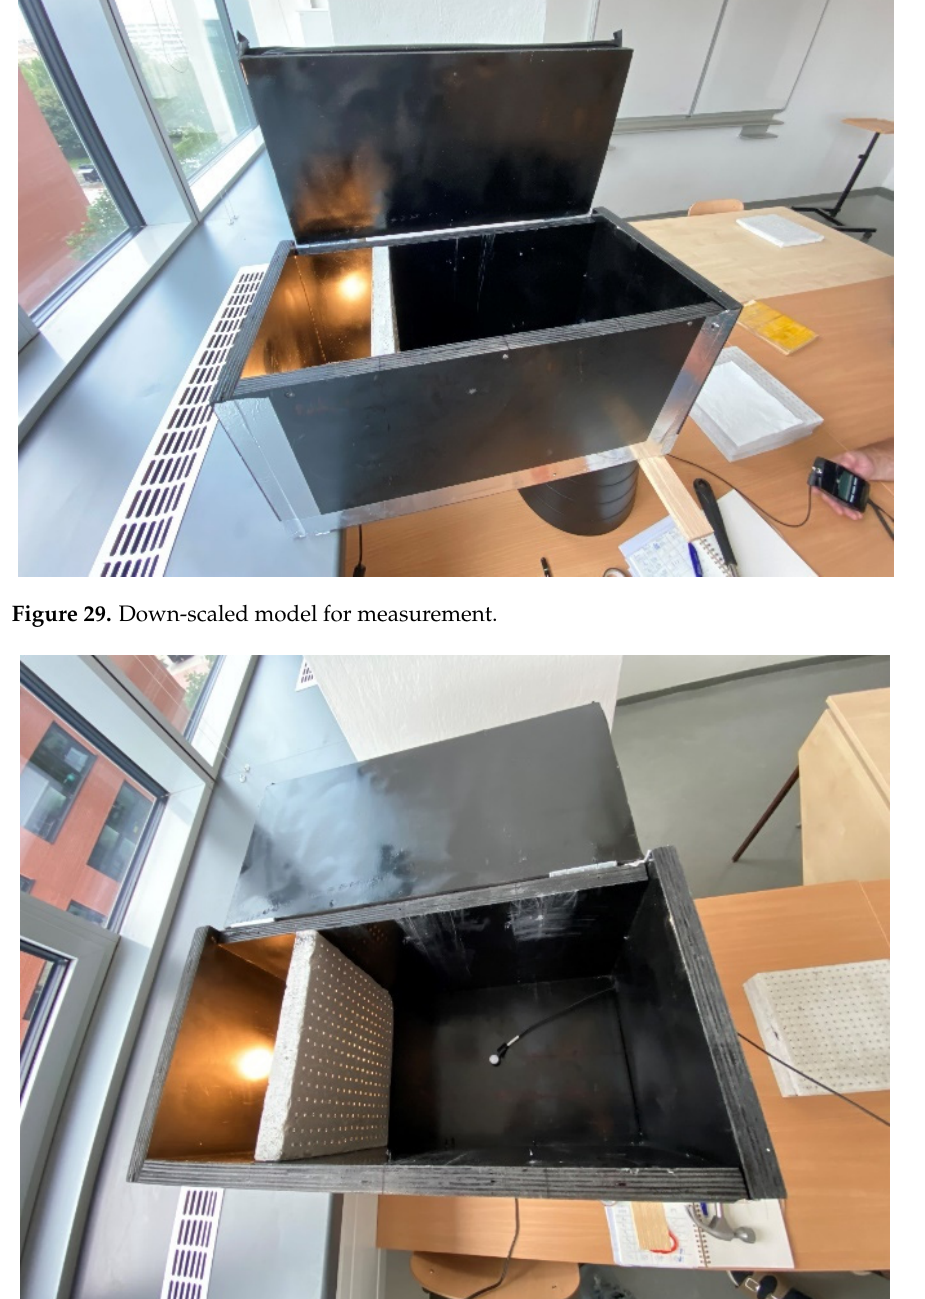
Figure 31. Plans and sections of the scaled-down model.